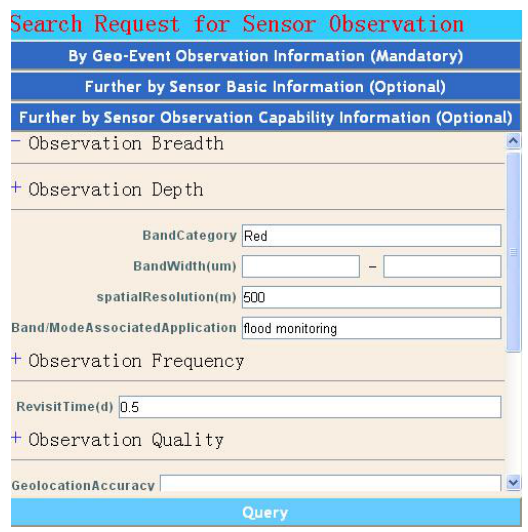
Figure 12. Further search request via fine-grained observation capability